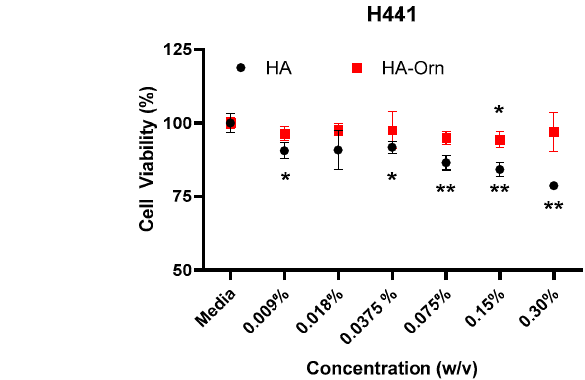
Figure 8. Cell viability was expressed as a percentage of control for Calu-3 and H441 cell lines after 24 h of exposure to HA and HA–Orn using MTS assay ( n = 3; mean ± St Dev). Statistical differences between the control and treatments were determined using an unpaired t-test with Welch’s correction (GraphPad Prism), and significance was considered when p < 0.05 (* p < 0.05; ** p < 0.01).